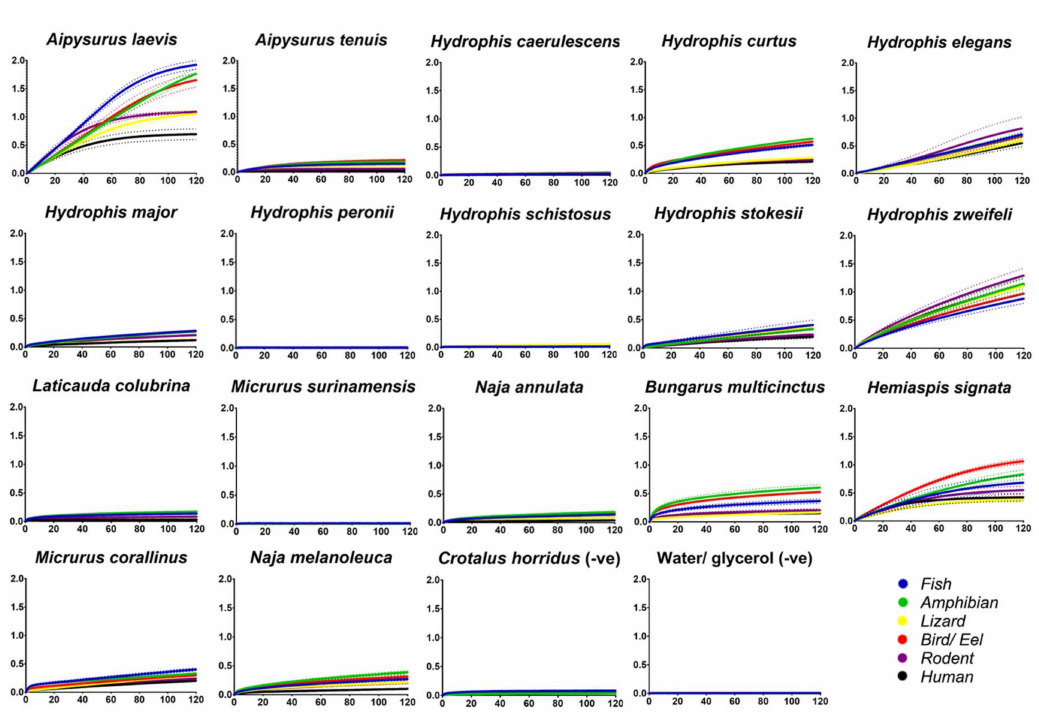
Figure 1. A binding comparison of crude venom from 17 species of aquatic elapids across α -1 nAChR mimotopes (fish, amphibian, lizard, bird / eel (both share the same sequence), rodent and human representatives). The two negative (-ve) controls are Crotalus horridus and 1:1 water / glycerol. Crotalus horridus was chosen as there is no evidence that this species utilises nAChR targeting neurotoxins, but will give a comparison of a venom that is rich in large non-binding toxin types (e.g., PLA 2 s, SVSPs and SVMPs [65,66]) which may cause a greater light shift than the water / glycerol -ve control. The Y-axis shows wavelength shift (nm) of the association (Ka binding step); the X-axis displays seconds (for the 120-s association period). All venoms were tested in triplicate. The dots surrounding the curve lines are error bars based on SEM values with n = 3. All raw data can be found in Supplementary File